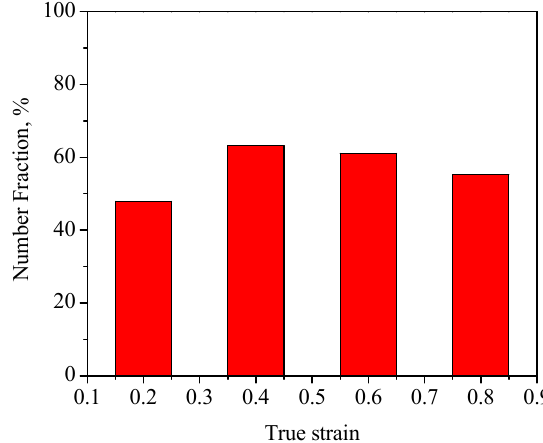
Figure 9. Variation of the number fraction of the misorientation angles in the range 2–15 ° with true strain.